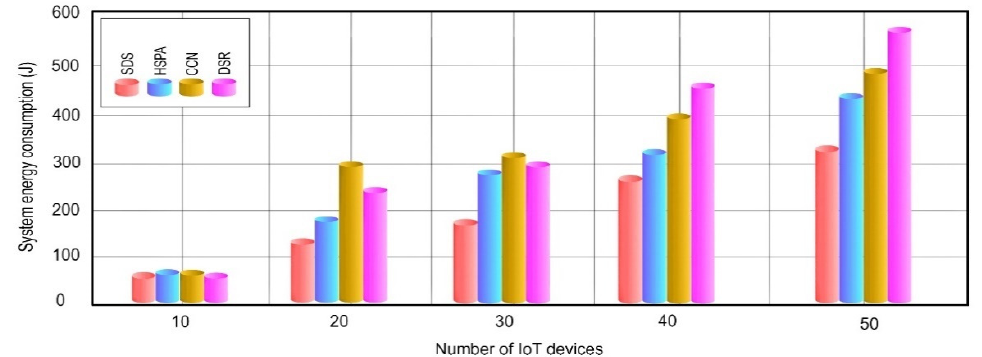
Figure 6. Overall system energy consumption.